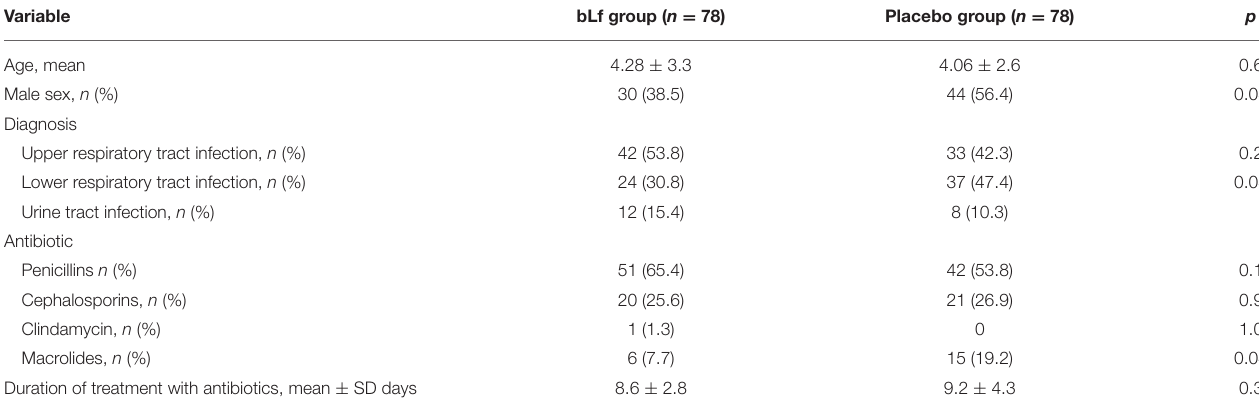
TABLE 1 | Baseline characteristics of the study